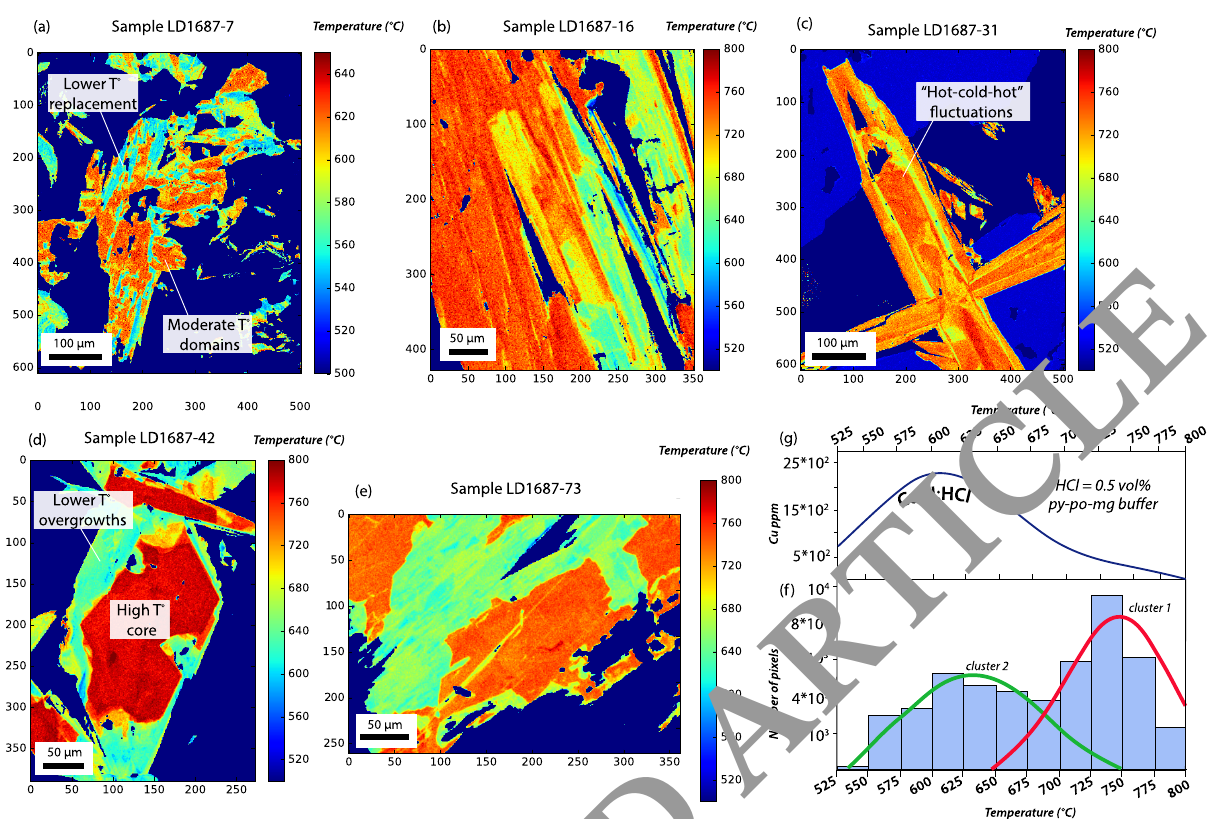
Fig. 3 Temperature variation and zonation of actinolite grains. a – e Grain-scale temperature maps of representative actinolite samples from drill core LD1687. f Histogram showing number of pixels extracted from temperature maps vs. actinolite temperatures. g Solubility curve of CuCl:HCl as a function of temperature for a HCl-bearing fl uid saturated with respect to chalcopyrite; f O 2 conditions correspond to the pyrite-pyrrhotite-magnetite buffer 46 . Temperature maps axis is scaled in